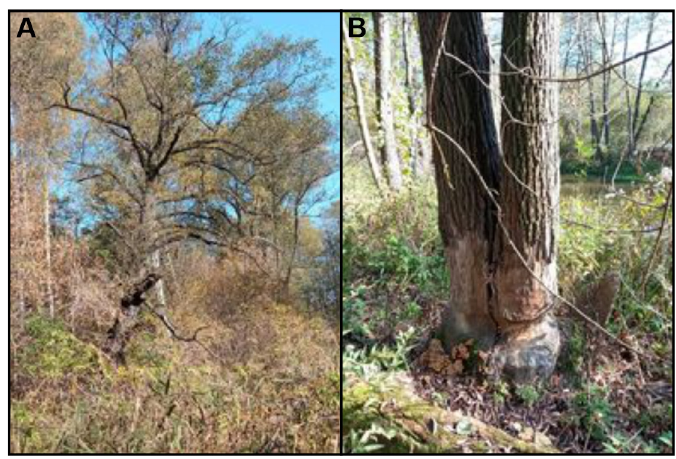
Figure 9. Fragment of the riparian forest ( A ) and traces of beaver activity ( B ).